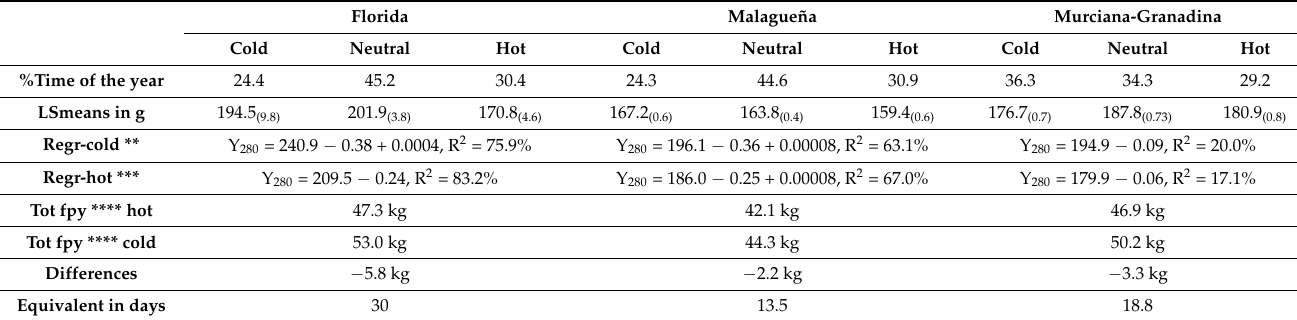
Table 2. Indicators of the effects of three THI * zones throughout lactation in three Spanish of dairy goat breeds.